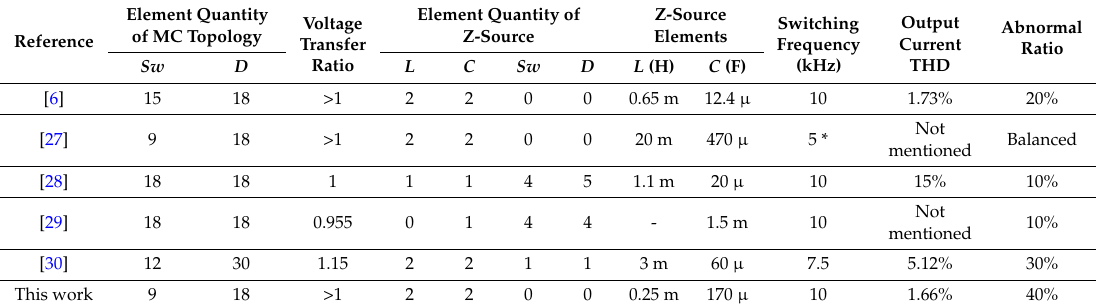
Table 2. Comparison of the performance of Z-source Matrix Converter with other